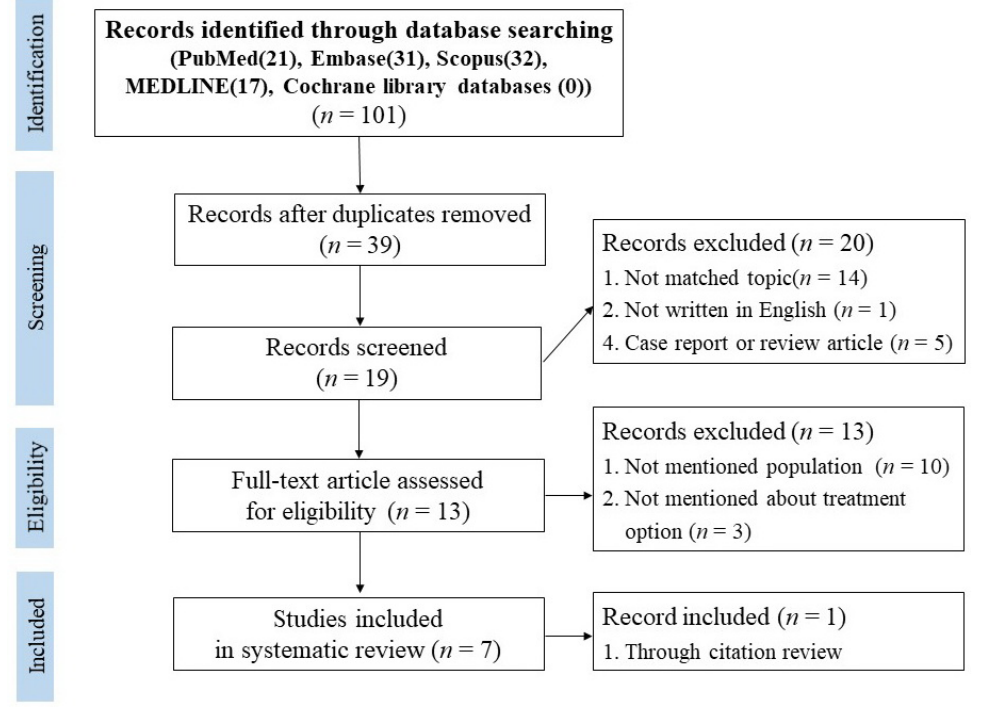
Figure 1. Preferred reporting items for systematic reviews.